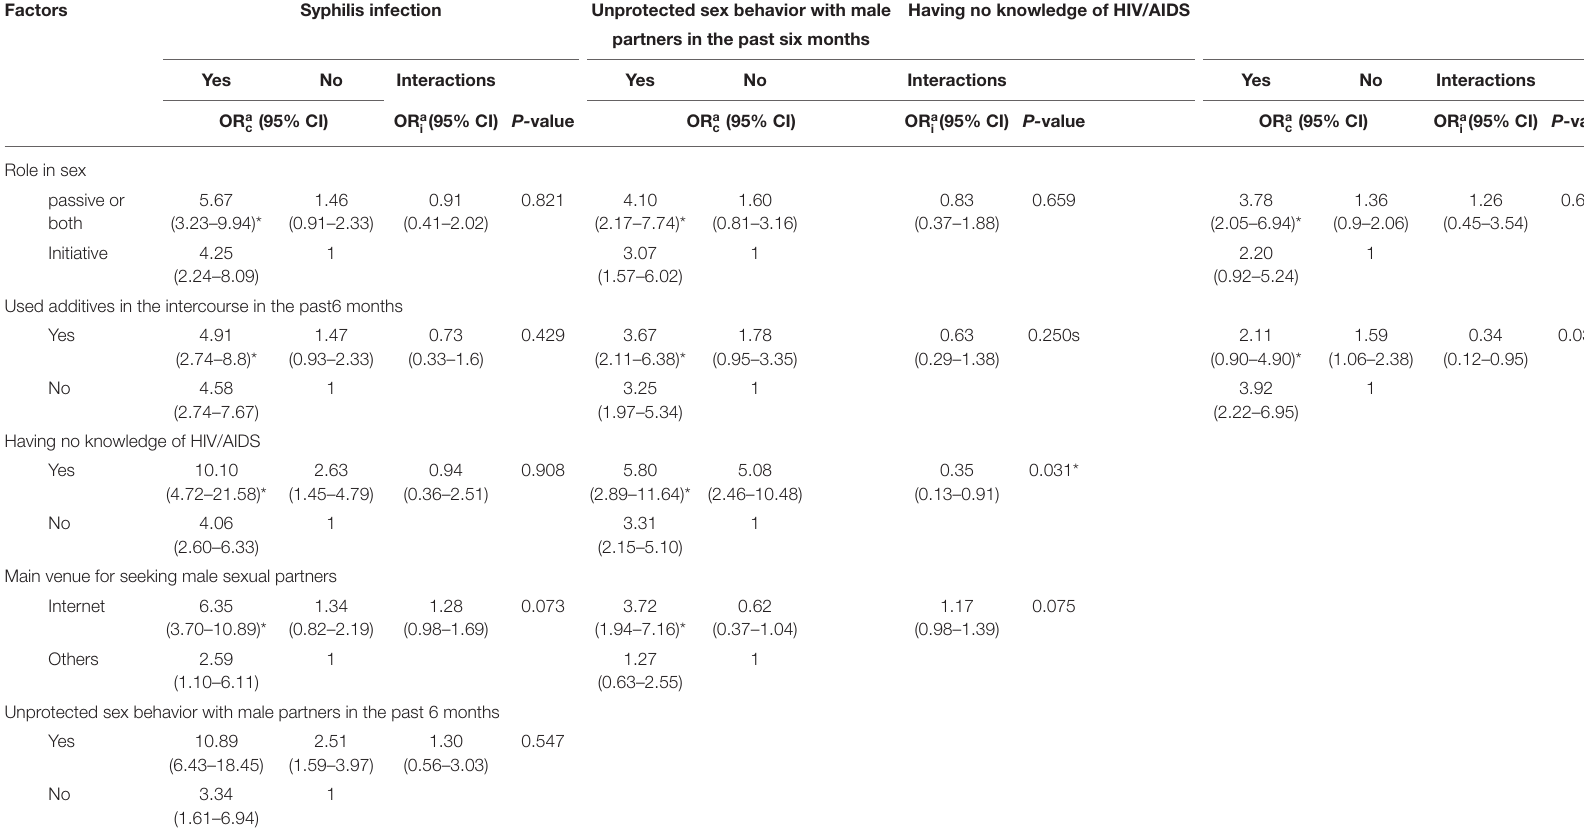
TABLE 3 | Effects of combination and interaction between factors on the risk of HIV sero-conversion. Factors Syphilis